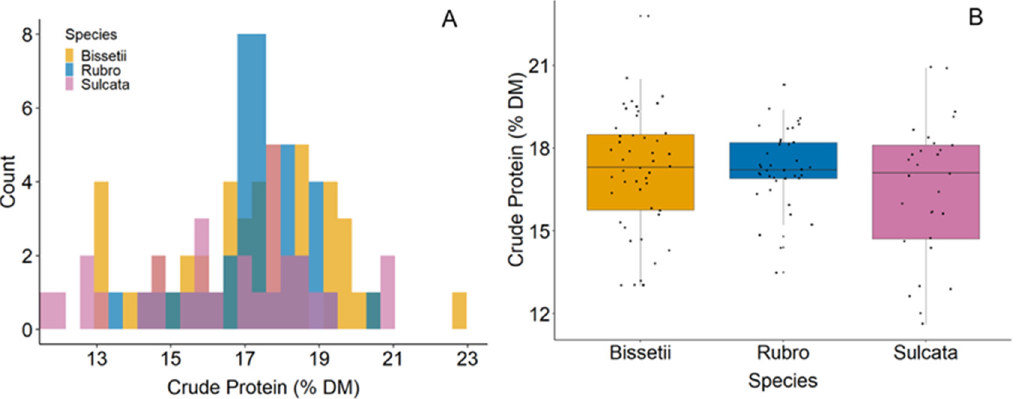
Figure 3. Distribution of crude protein of bamboo samples grouped by species presented by the histogram ( A ) and boxplot ( B ).